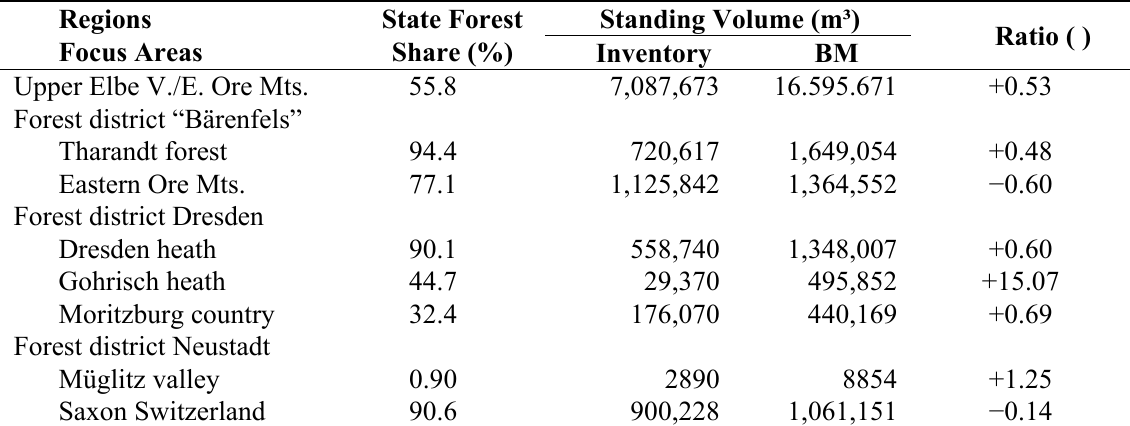
diameter of the owner type state forest. Comparison of the inventory data of the state forest (first row) and seven focus